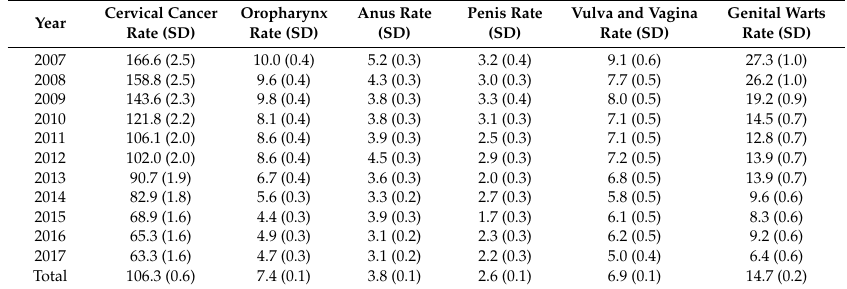
Table 1. Hospitalization rates (per 100,000 person-years) of human papillomavirus (HPV)-related diseases in